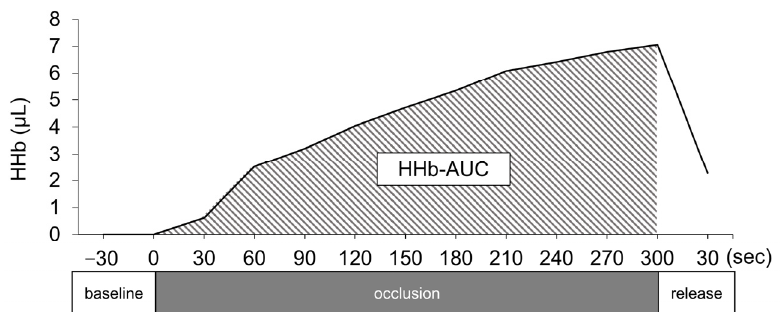
Figure 3. Overview of analysis of the area under the curve of deoxygenated hemoglobin. HHB, deoxygenated hemoglobin; HHb-AUC, area under the curve of HHb.